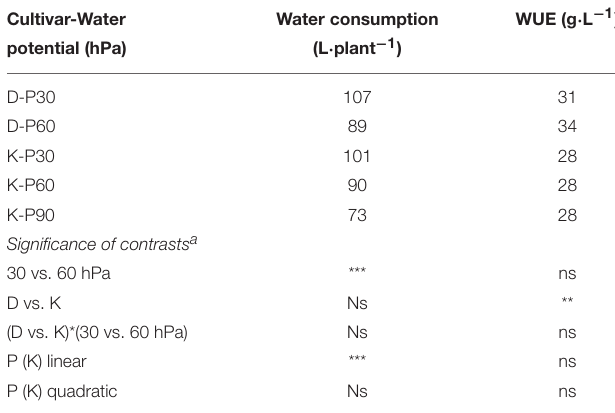
TABLE 4 | Effect of cultivar (Diana—D and Kabiria—K) and growing-media matric potential (P) on water ( 9 i ), osmotic ( 9 o ), and turgor ( 9 t ) pre-dawn potential and noon water potential on covered leaf ( 9 x ) of subirrigated soilless tomato under controlled water stress conditions. Cultivar-Water potential (hPa)